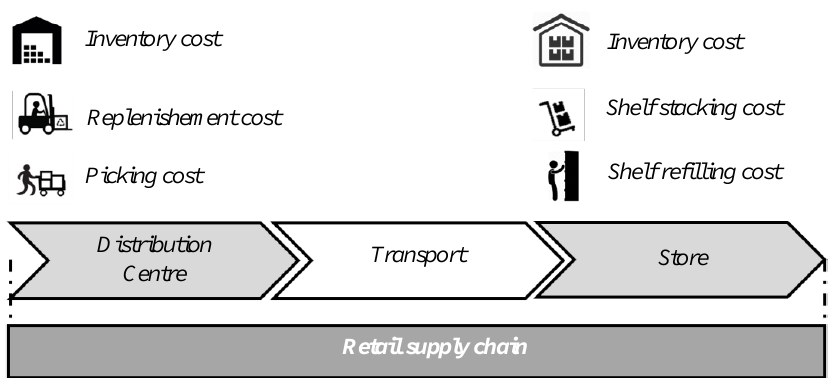
Figure 3. Cost components considered in the